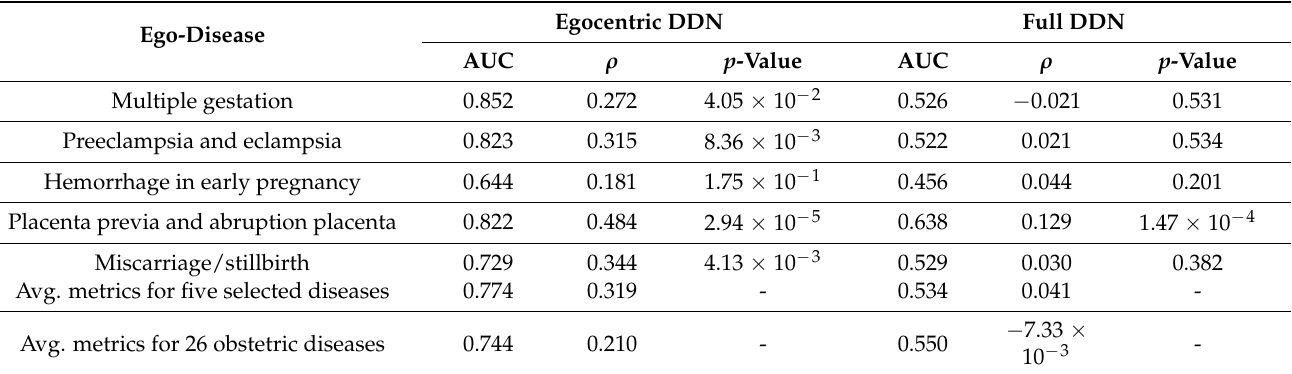
Table 2. Experimental results of our GSSL scoring algorithm, compared to EHR-derived disease co-occurrences. The use of our method on egocentric networks significantly boosts our ability to identify potential disease comorbidities based upon the genetic information encoded in the DDN. GSSL, graph-based semi-supervised learning; EHR, electronic health record; DDN, disease–disease network; AUC, area under the receiver operating characteristic